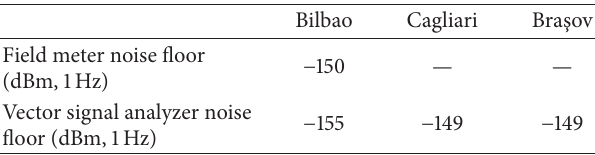
Table 3: Measurement system features.